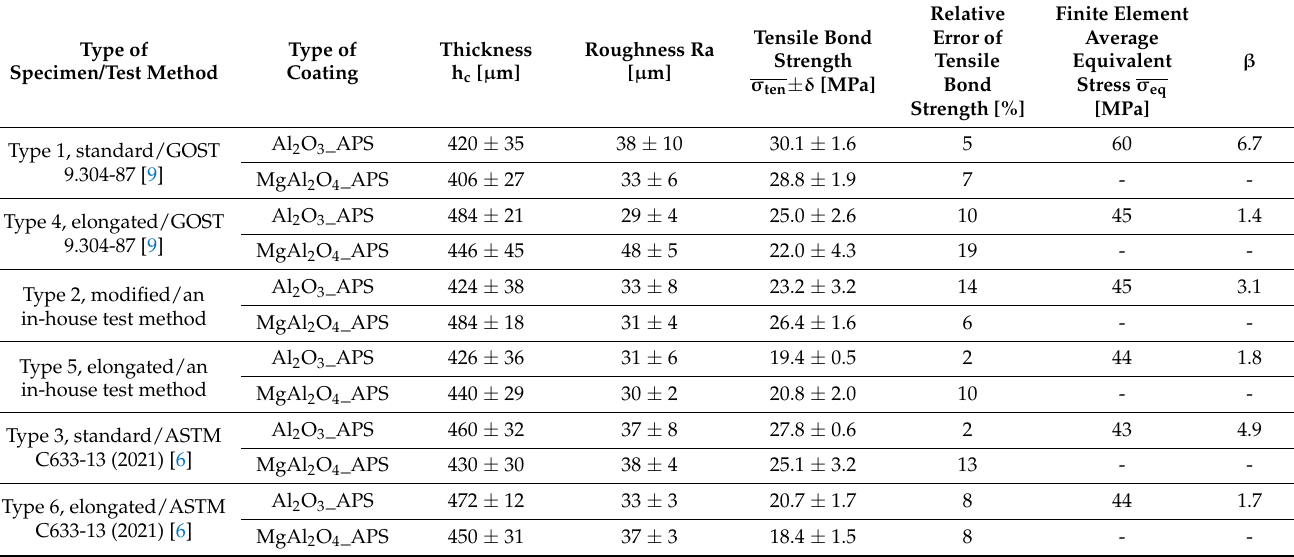
Table 2. Summary results of tensile bond strength measurements for APS—MgAl 2 O 4 , Al 2 O 3 and finite element surface stresses on standard and elongated